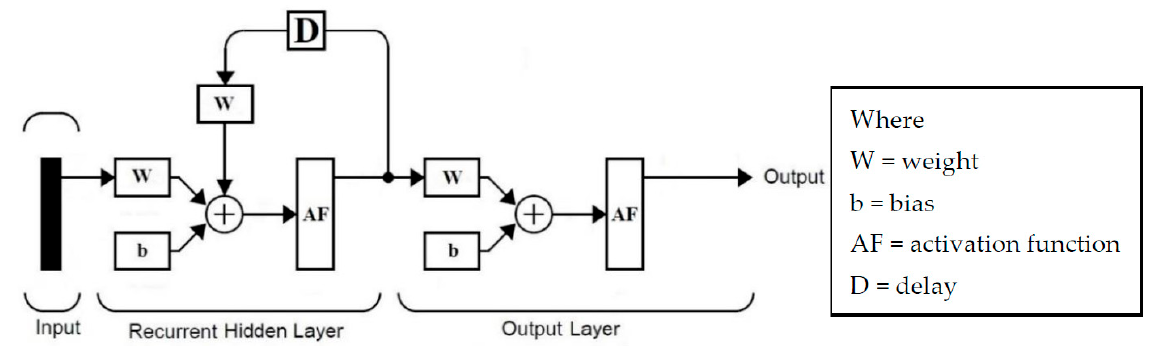
Figure 3. Three-layered RNN model.